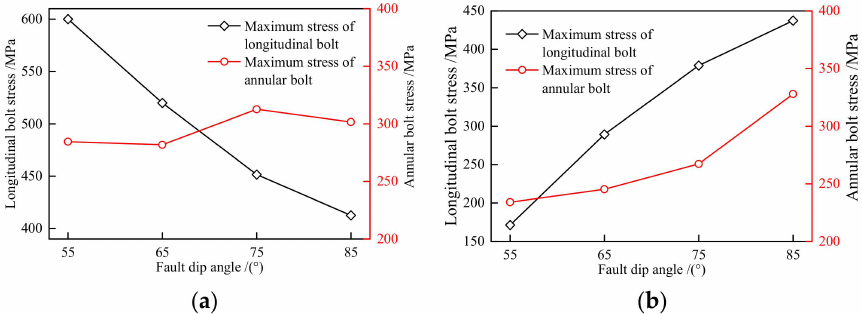
Figure 26. Effect of the fault dip angle on the maximum stress of joint bolts: ( a ) normal faulting condition and ( b ) reverse faulting